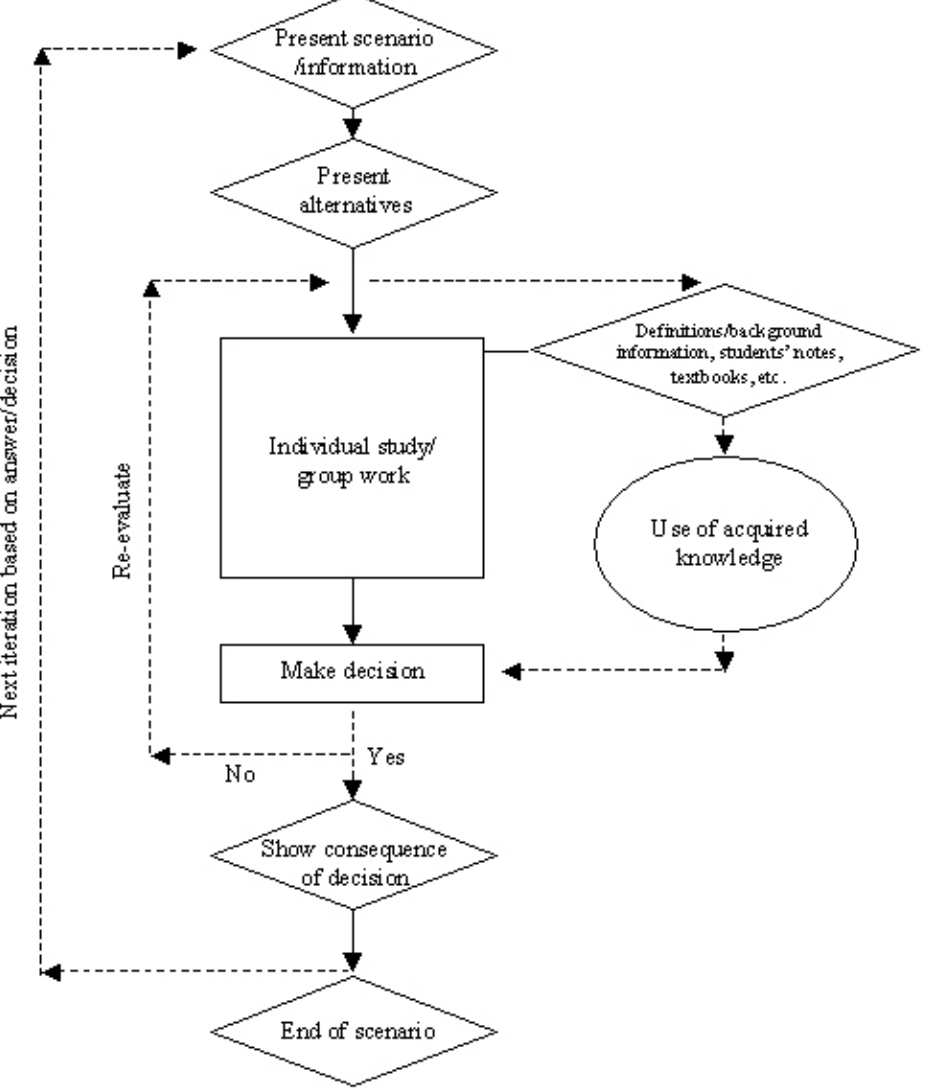
Figure 4. Structure of inPractice (diamond, information given by the program; square, student activity; circle, application of